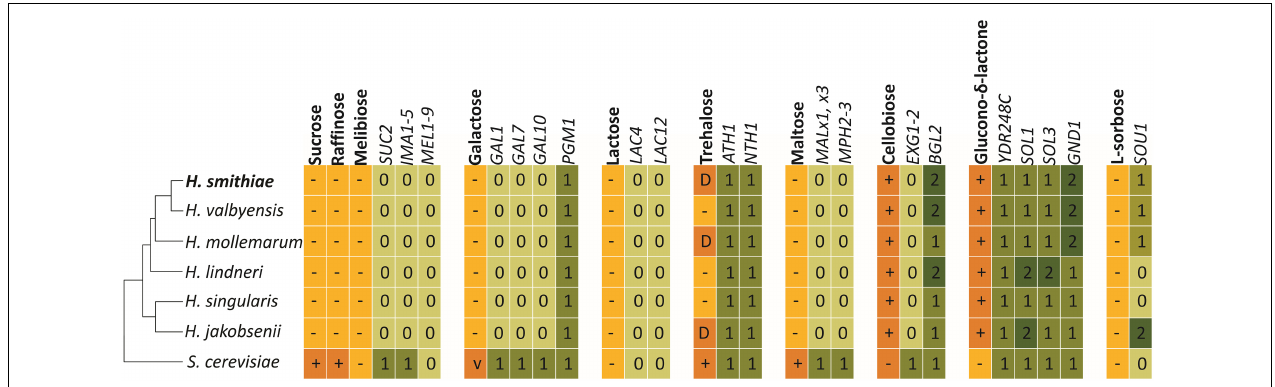
FIGURE 6 | Metabolic traits and genes involved in the assimilation of carbon sources included in standard phenotypic characterization by Hanseniaspora smithiae , its closest relatives, and Saccharomyce cerevisiae (S288C). Numbered boxes indicate presence (1) or absence (0) of putative homologous genes, as determined using the BLASTP and TBLASTX